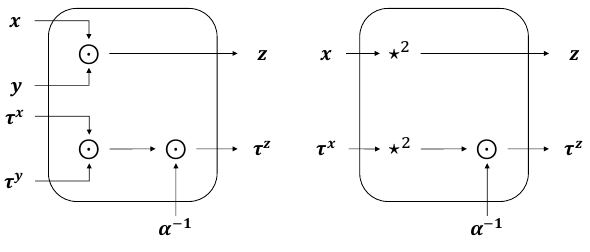
Figure 3: M&M nonlinear operations: Obtaining the value and tag shares of z = xy (left) and z = x 2